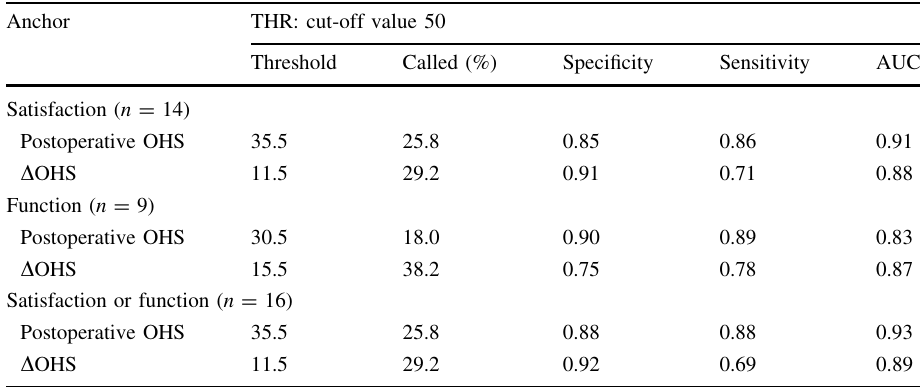
True positives is the amount of patients who should be called according to the cut-off value n number of patients with anchor values below the cut-off value